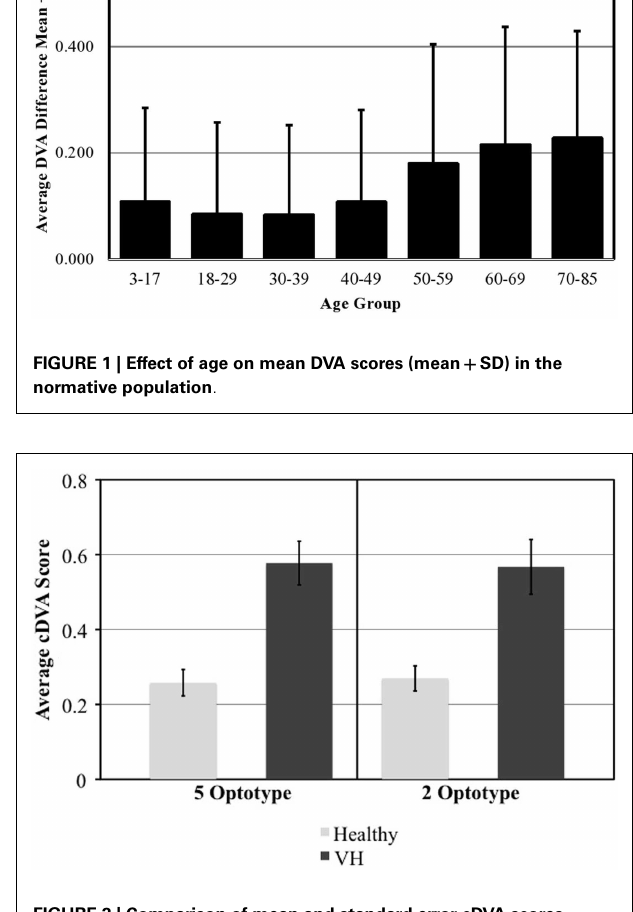
FIGURE 2 | Comparison of mean and standard error cDVA scores between those with and without vestibular hypofunction (VH) in the short (2 optotypes) and long (5 optotypes) version of the test.